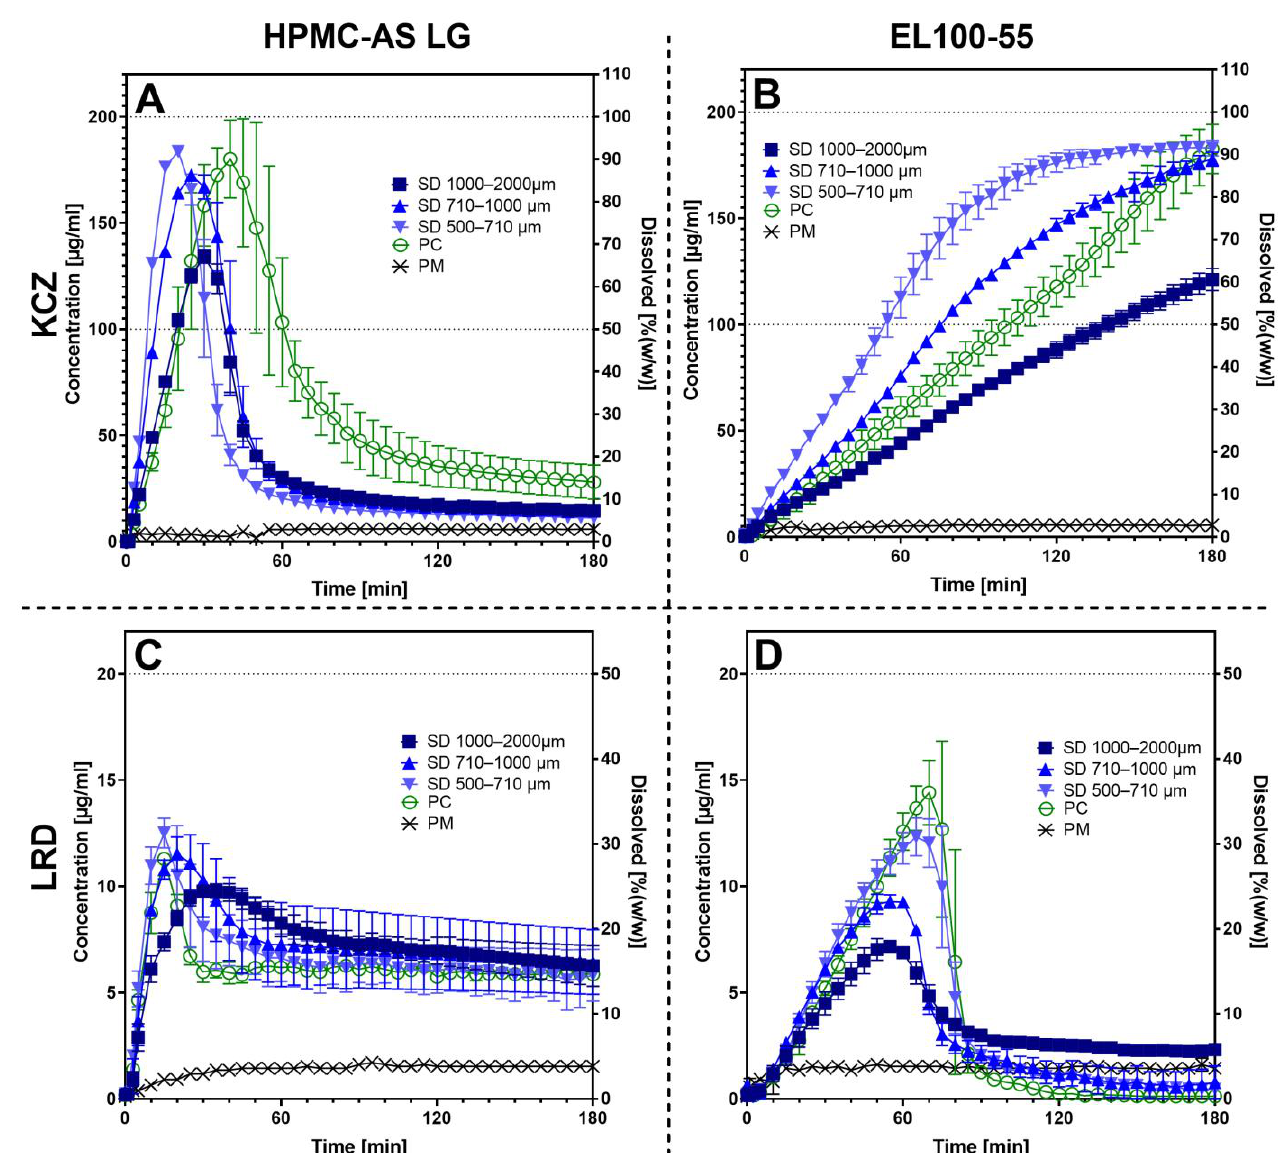
Figure 6. Dissolution profiles of all prepared samples containing ( A ) KCZ and HPMC-AS L; ( B ) KCZ and EL100-55; ( C ) LRD and HPMC-AS; and ( D ) LRD and EL100-55. Coated pellets are represented by green open circles ( ◯ ). The different sieve fractions of the SD are represented by blue filled symbols, with squares for 1000 – 2000 µm ( ■ ), triangles for 710 – 1000 µm ( ▲ ), and turned triangles for 500 – 710 µm ( ▼ ). The physical mixtures are presented by black crosses (×). The dissolution was observed at pH 6.8 in PBS-buffer over a period of 180 min.